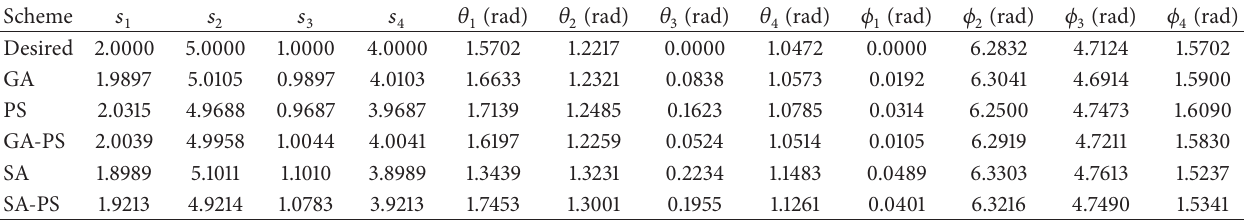
Table 8: Performance of 2-L-type array for sources located on reference axis.